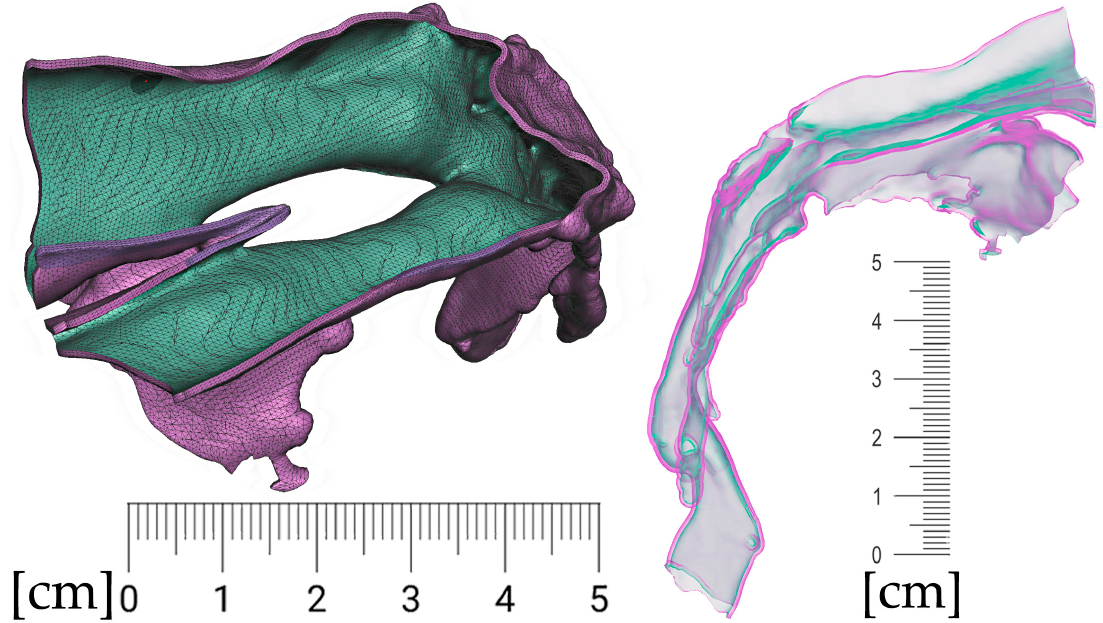
Figure 8. Segmentation of the airway from CT scan in the area between nasopharynx and oropharynx; knowledge of the morphology is important for the design of the spur shape, especially in craniofacial syndromes with palatal cleft.